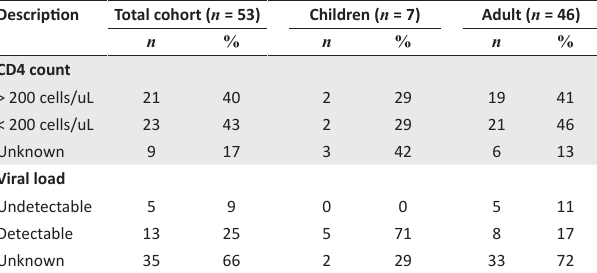
TABLE 2: Human immunodeficiency virus status of human immunodeficiency virus-infected patients.